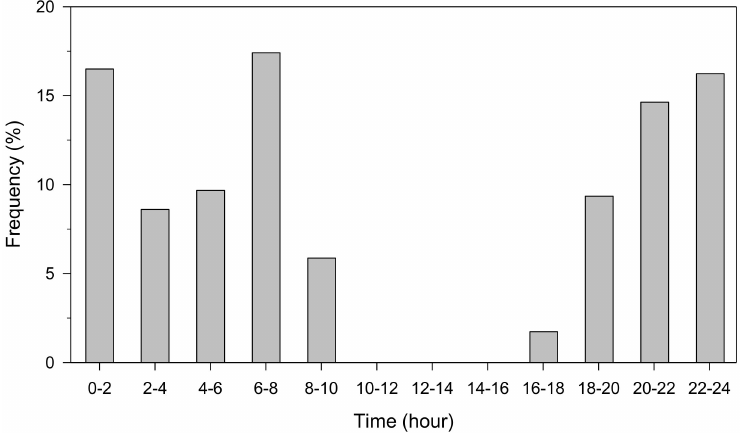
Figure 6. Frequency of hours with conditions favorable to growth, i.e., positive precipitation values and VPD < 0.24 kPa. Values were binned with 2 h